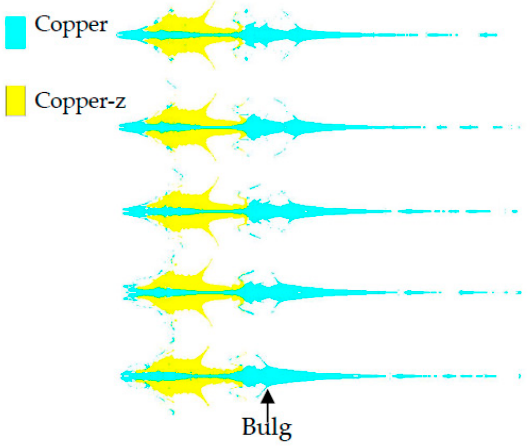
Figure 10. Jets formed by different wall thickness of confined cylinder.